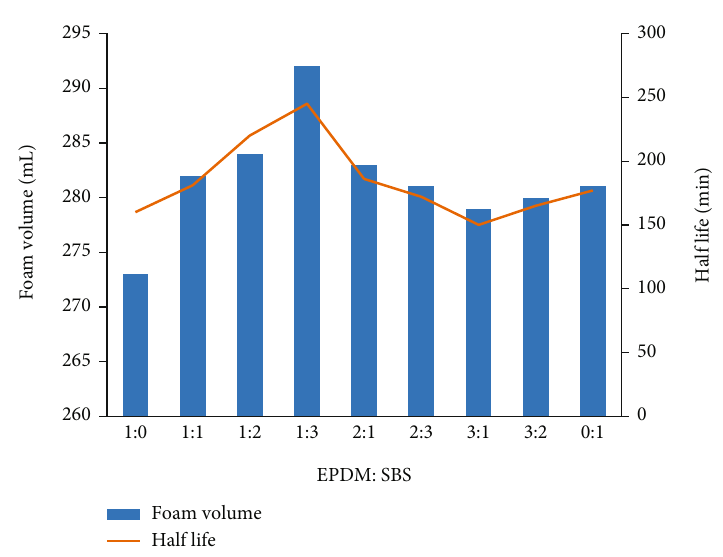
Figure 9: Foam stabilization performance of the mixed system of EPDM and SBS in di ff erent